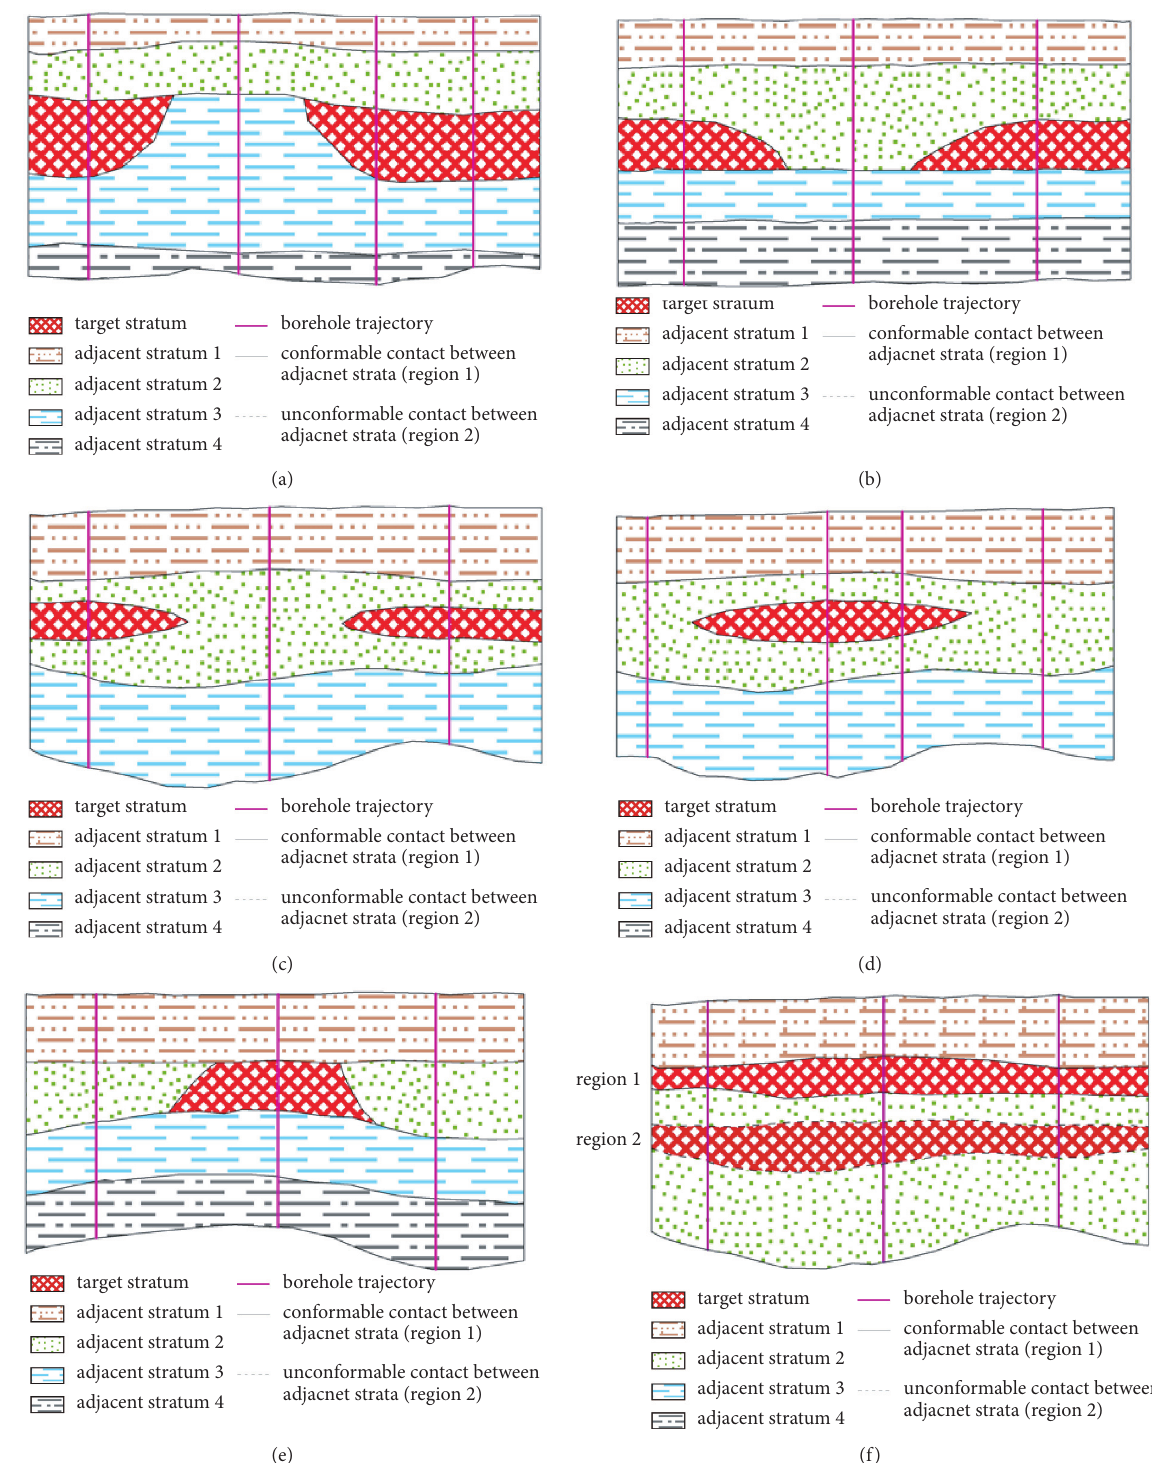
Figure 1: Spatial distribution characteristics of typical engineering layer: (a) stratum upward pinch-out, (b) stratum downward pinch-out, (c) left and right lens, (d) typical lens, (e) two-side pinch-out, and (f) complete section lines of the underlying strata, and its top section line strata, and its bottom section line can be drawn by expert can be drawn by expert knowledge or interpolation. The top knowledge or interpolation. While the bottom section line of and bottom section lines of the lenses are spatially separated the stratum downward pinch-out is controlled by the top